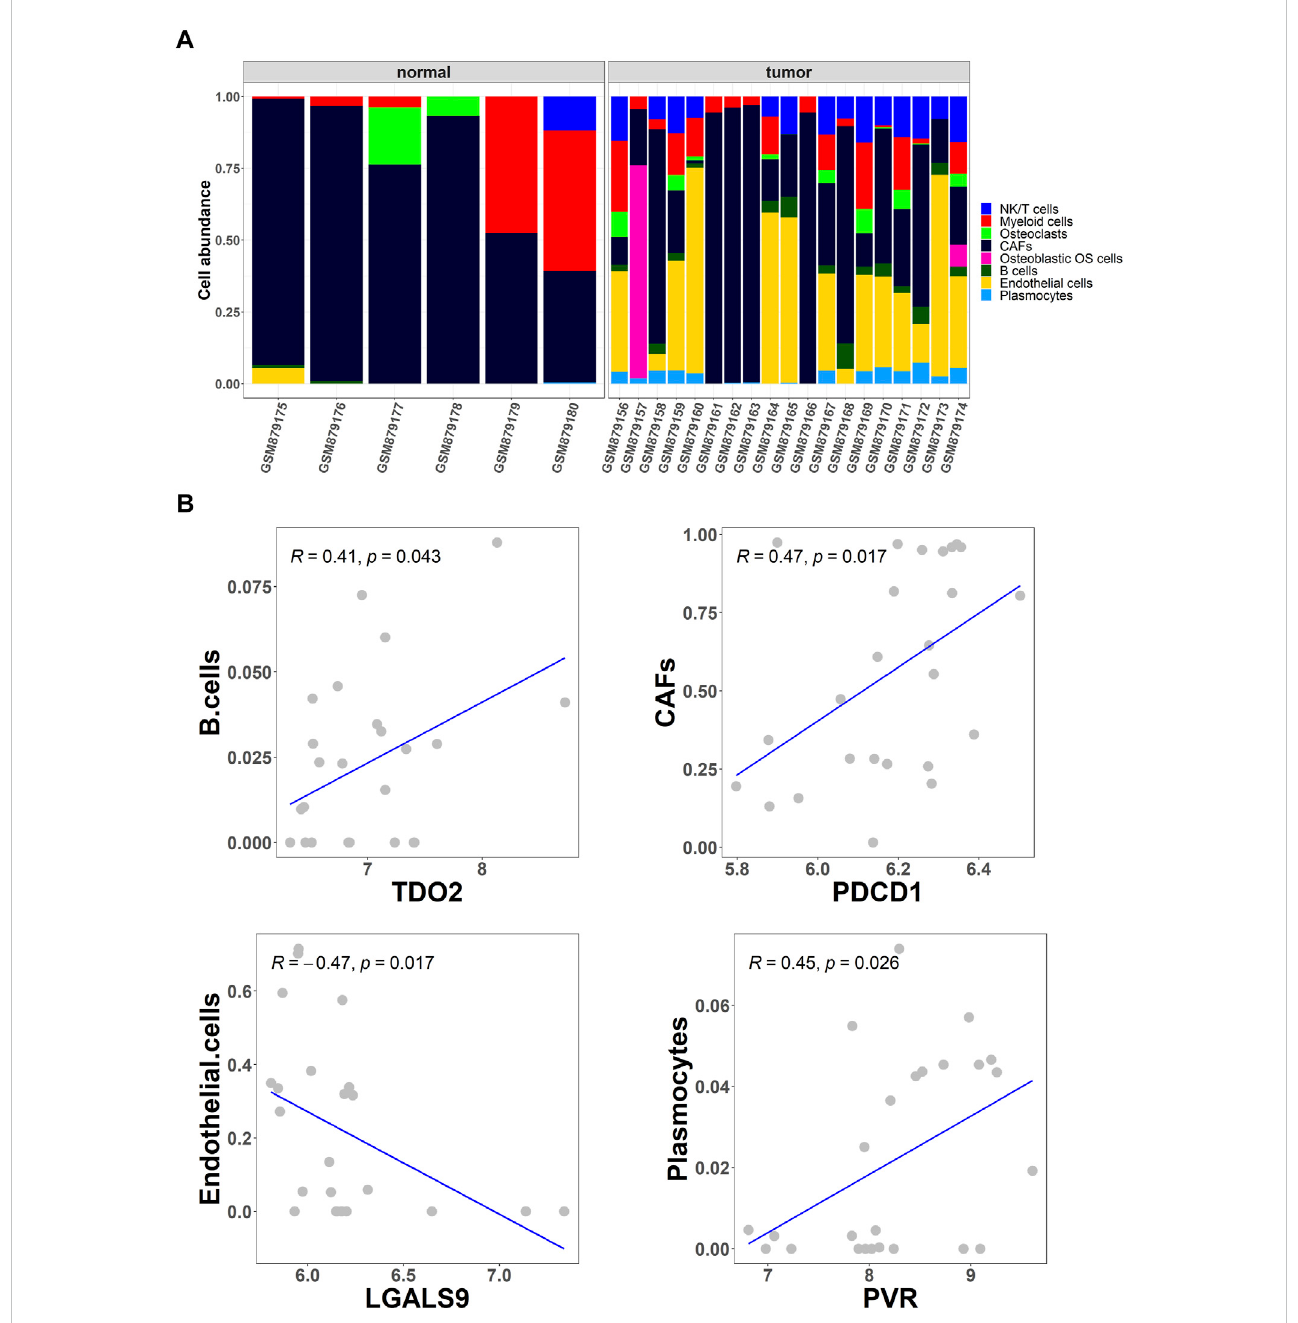
FIGURE 2 Collection of differential cell types. (A) The CIBERSORT algorithm was used to obtain the differential abundance of eight cell types in OS and normal tissues from the GSE36001 dataset; (B) Scatter plot of the correlation between the abundance of the four cell types (B cells, cancer-associated fi broblasts (CAFs), endothelial cells, and plasmocytes) and the expression of immune checkpoints TDO2, PDCD1, LGALS9, and